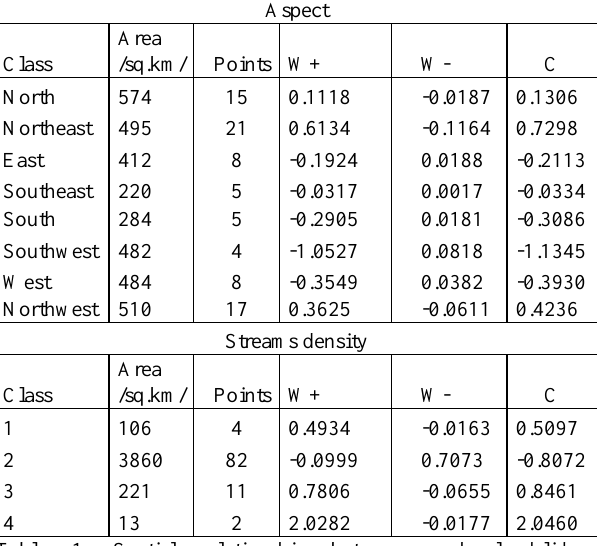
Table 1. Spatial relationship between each landslide conditioning factor and landslide by WOE model.